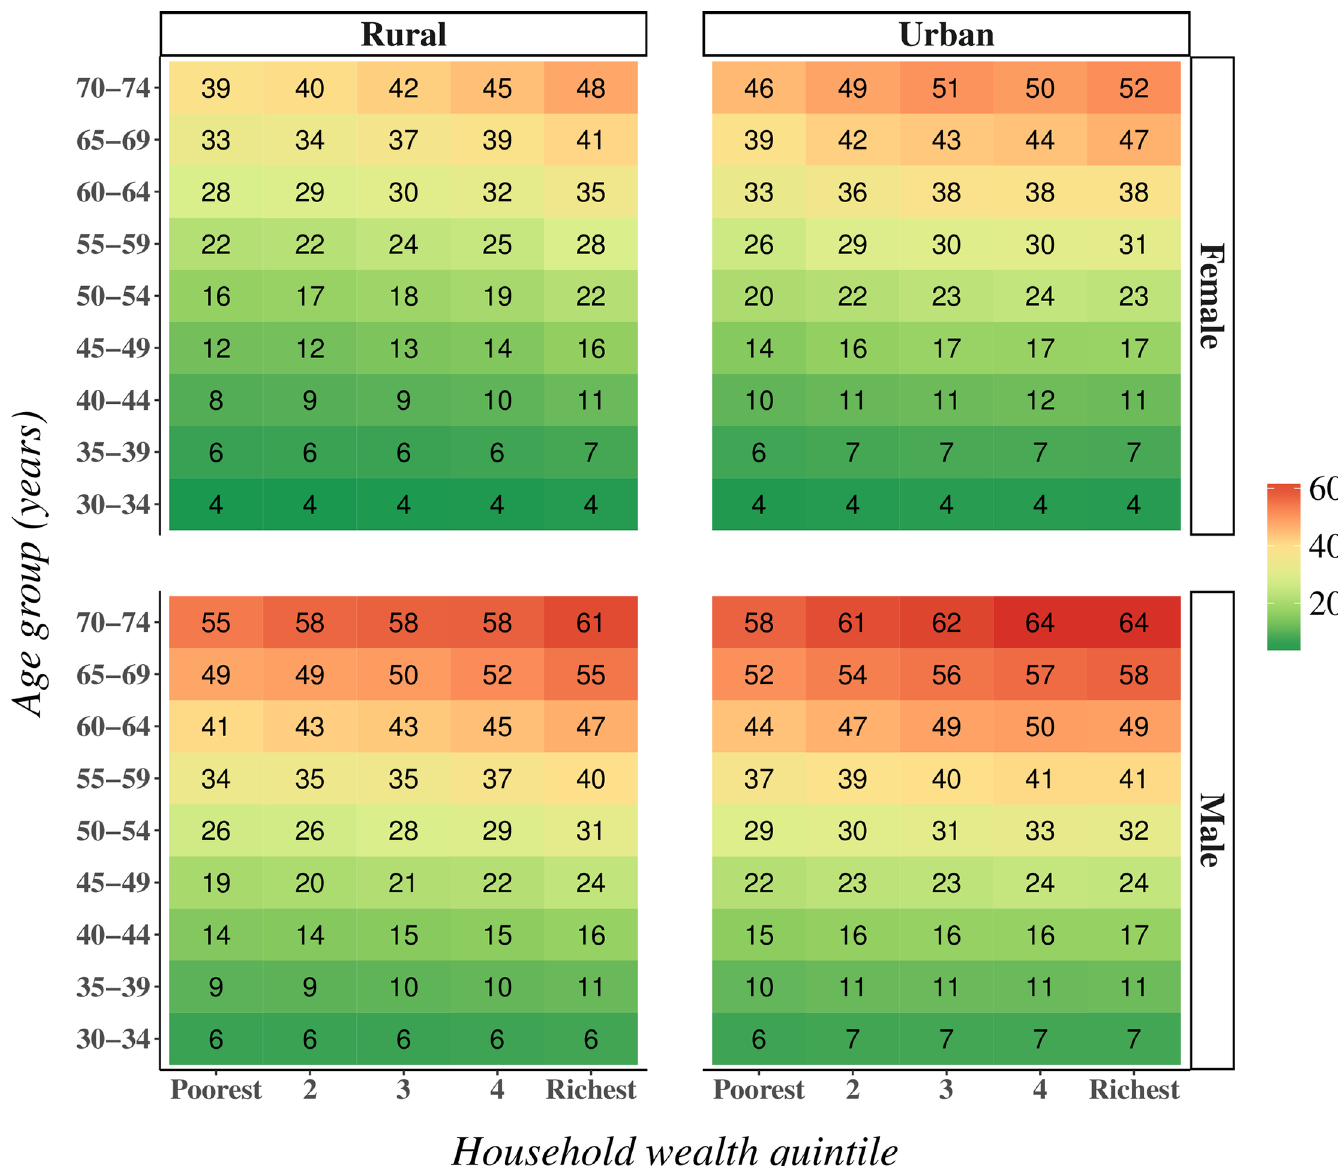
Fig 7. Crude mean 10-year cardiovascular disease risk by household wealth quintile, age group, rural versus urban location, and sex. This is the crude (i.e., not age- standardized) mean 10-year risk (in percent) of a cardiovascular disease event as calculated with the Framingham risk score.